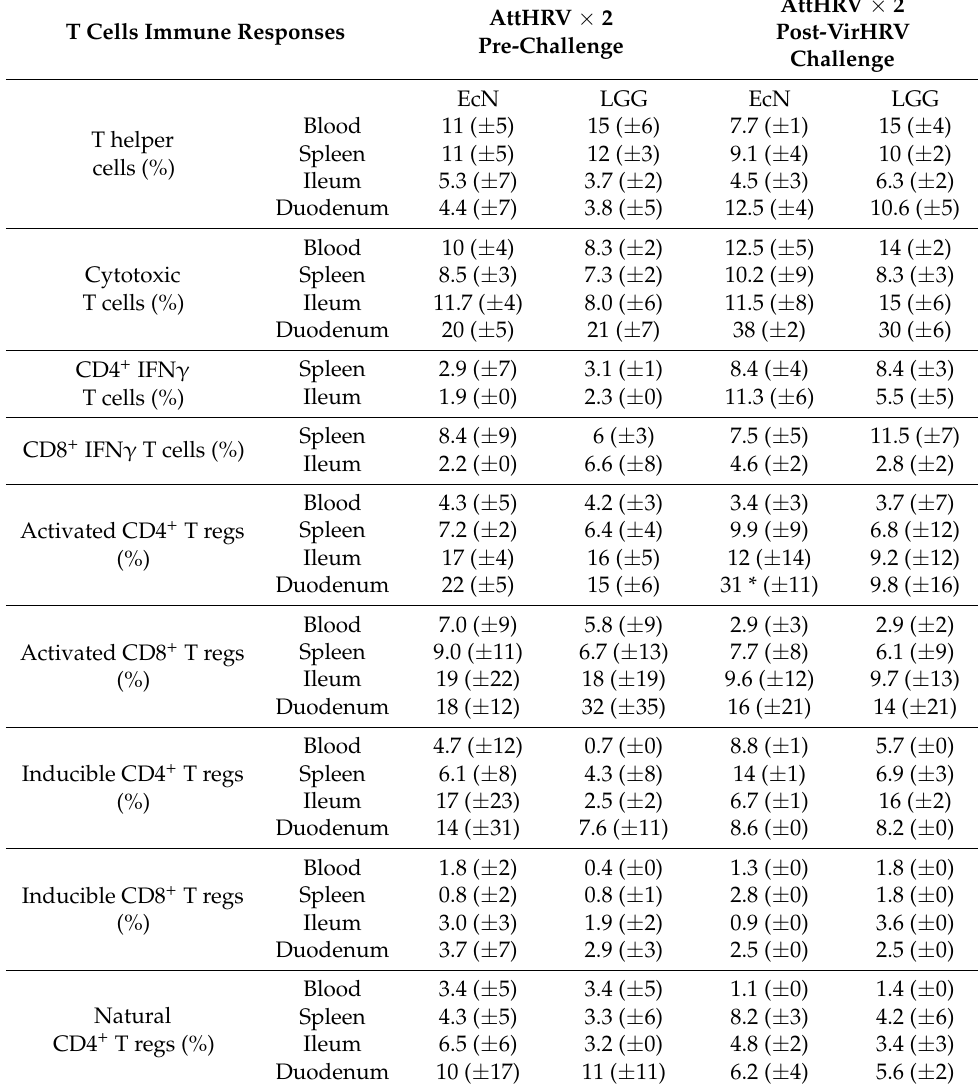
Table 3. EcN colonization altered the frequencies of T helper cells, cytotoxic T cells, HRV-specific IFN- γ producing T cells, CD4 + /CD8 + activated, inducible, and natural T regulatory cells in tissues.